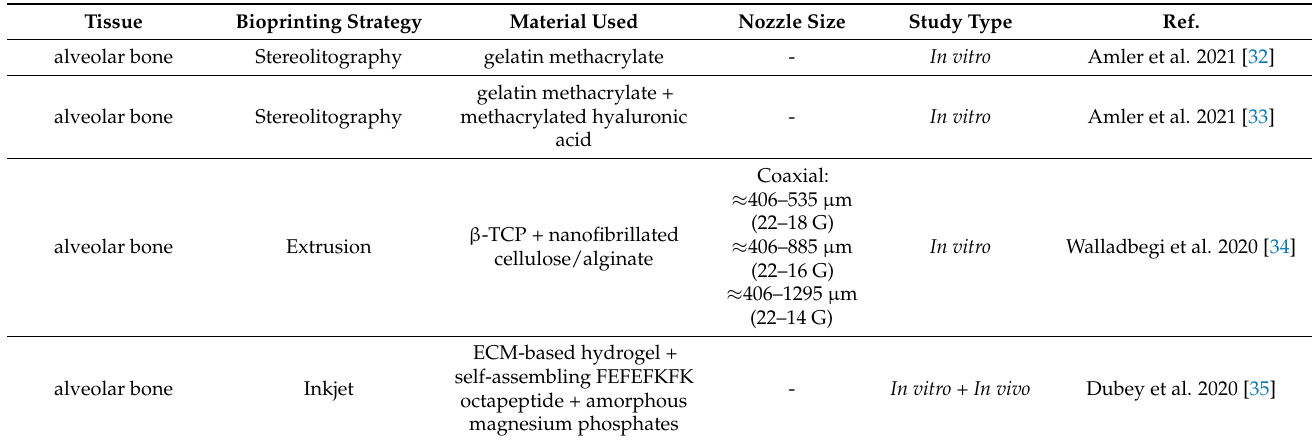
Table 1. Overview of the research on bioprinting of dental pulp, periodontal ligament and dentoalve- olar bone published in English up to November